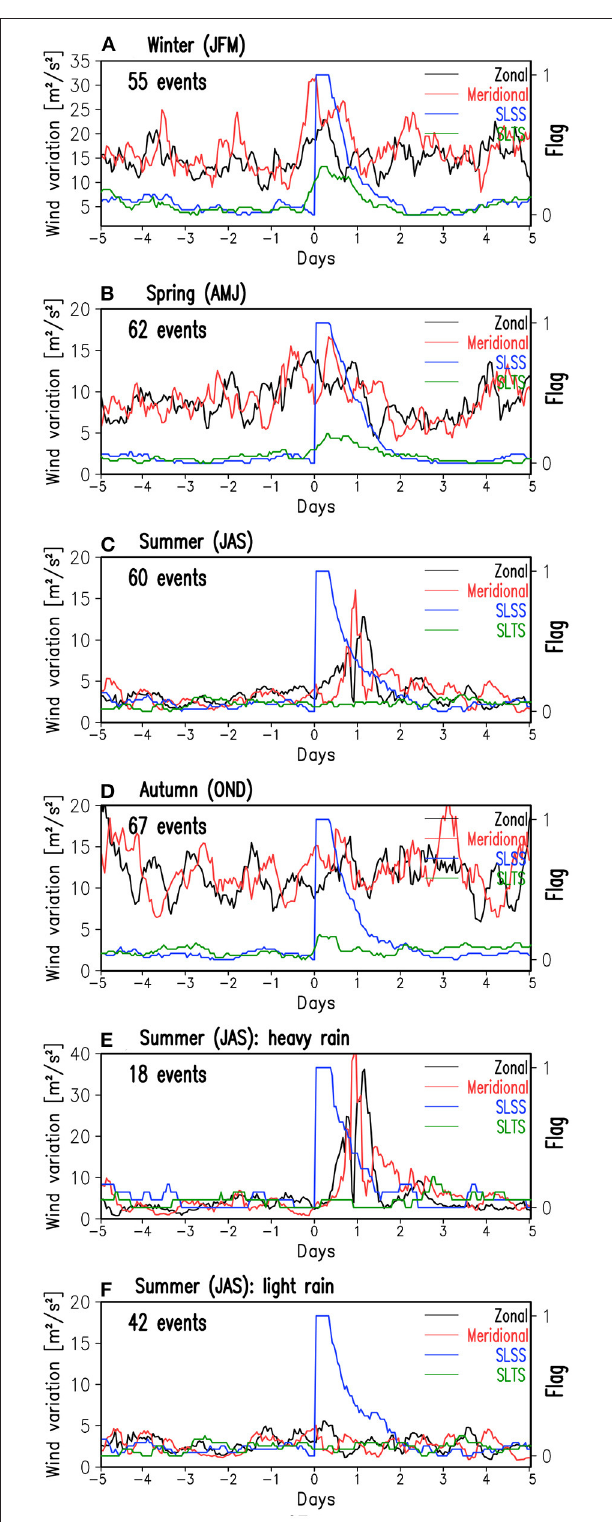
FIGURE 6 | (A–F) Same as Figure 5 except for black and red lines showing the zonal and meridional components, respectively of wind velocity subdiurnal variation (WVDV) given by equation (4) with a unit of m 2 / s 2 . WVDV has been calculated using 10m wind velocity in the JRA55-do 3-hourly